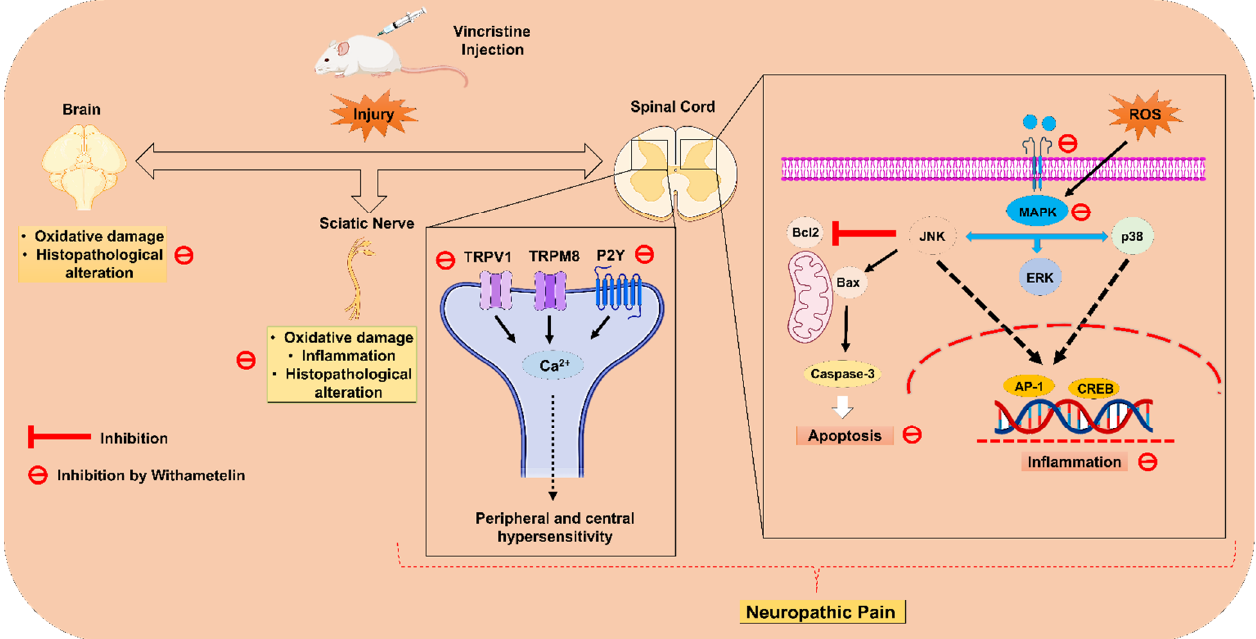
Figure 17. The proposed molecular mechanism of withametelin in the vincristine model of neuropathic pain. Created with BioRender.com, accessed on 1 May